Question: Describe this figure in one sentence.
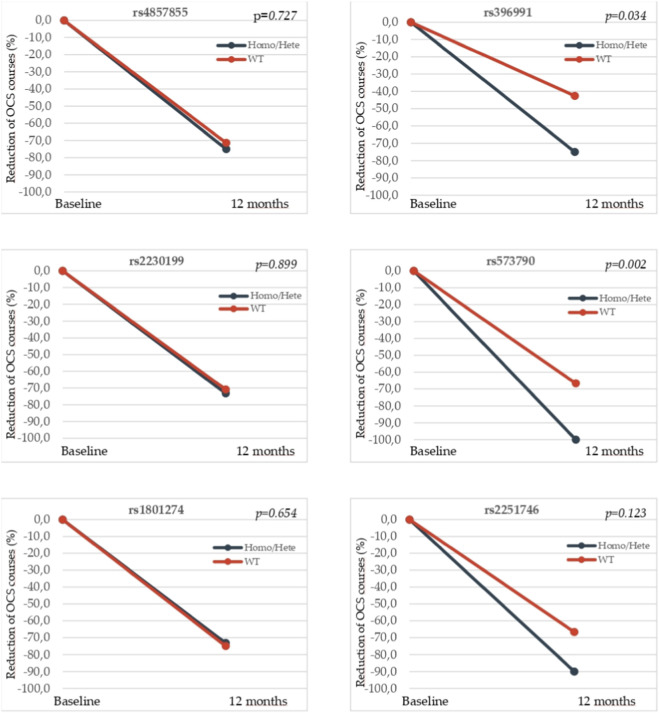
Answer: Percentage reduction in OCS courses after 12 months of omalizumab treatment by genotype. Median percentage reduction in the number of OCS courses observed in wild-type (WT) versus variant allele carriers for each SNP. Statistical comparisons performed using the Mann–Whitney U test.